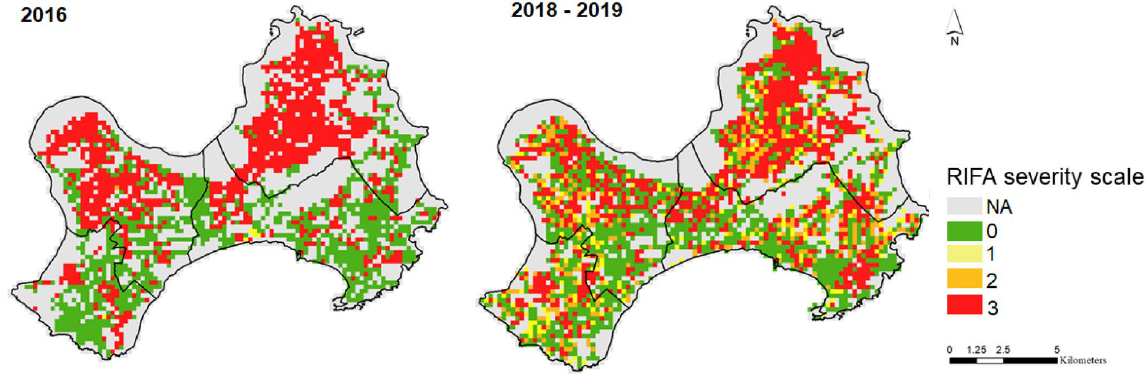
Figure 3. Distribution of RIFA severity in 2016 and 2018–2019. Areas with no sampling tubes were denoted as NA. This map is generated by ArcGIS 10.7 19